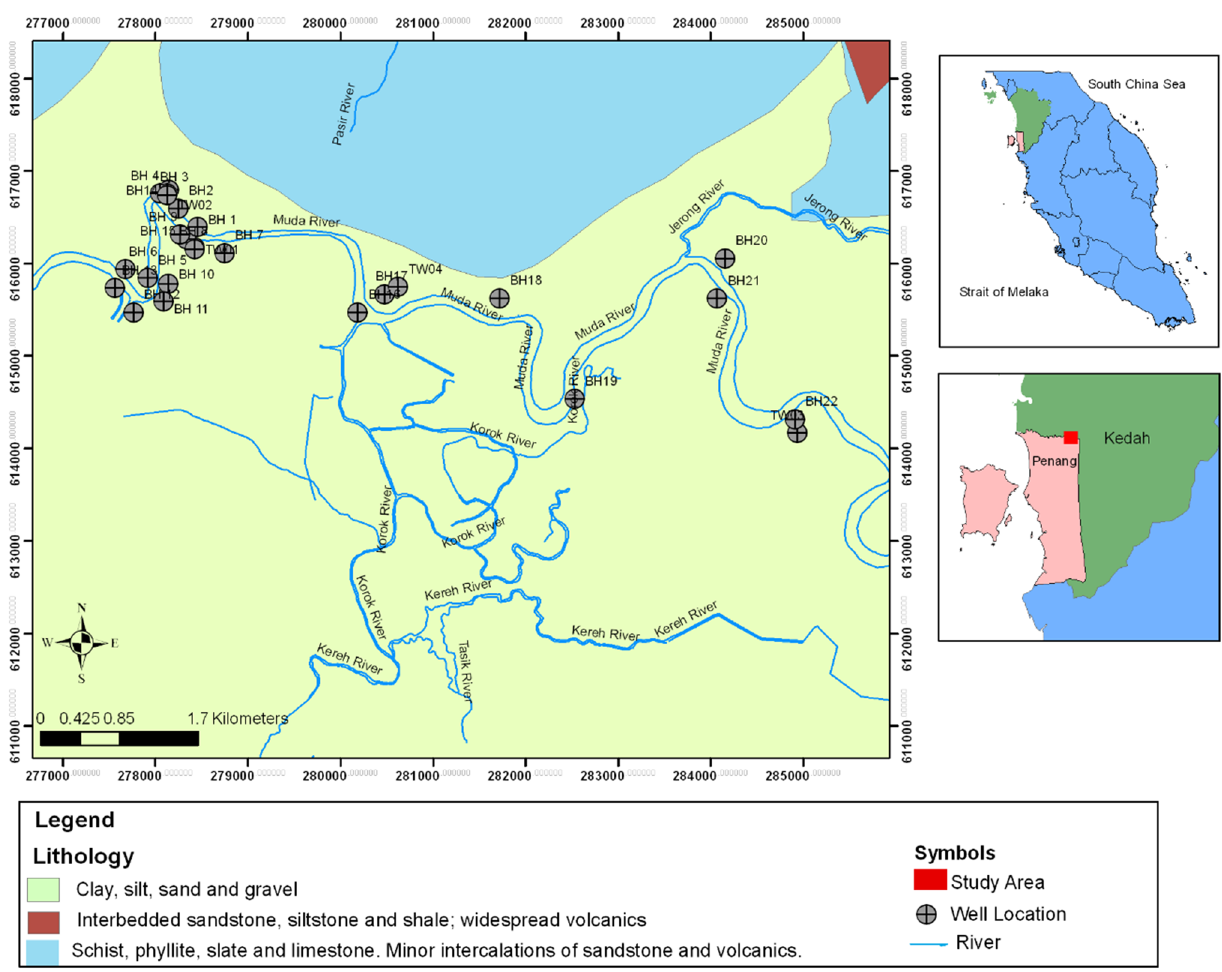
Fig. 1 Geology and location of the study area located at two states Penang and